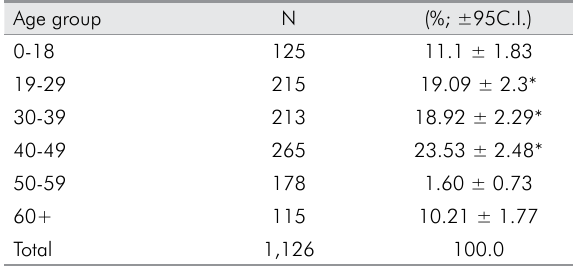
Table 1. Age distribution and percentage of the total sample (n = 1,126) Age group N (%; ±95C.I.)